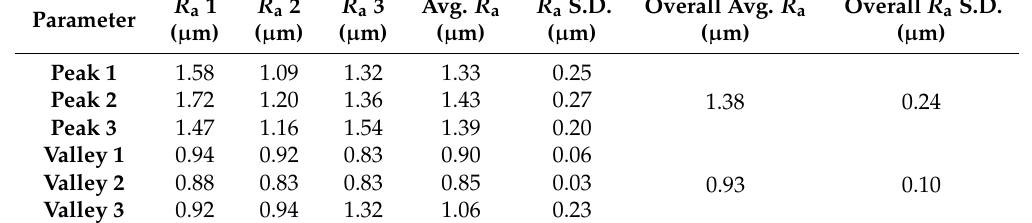
Table 2. Surface roughness values of different peaks and valleys that were randomly selected along the ceramic implant.